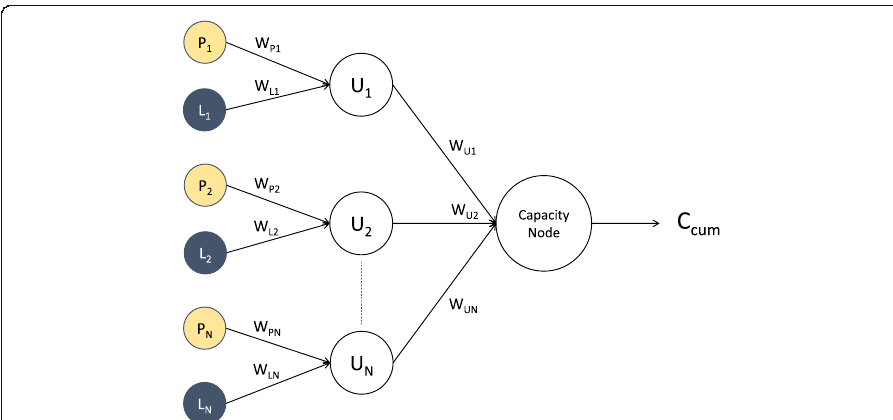
Fig. 4 Architecture of the prediction engine. Probabilities from an individual ’ s user preferences (yellow) and vehicle locations (blue) at the time of the potential market opportunity are input to a layer of nodes for each of the N users (U 1 to U N ). The capacity node predicts overall capacity (C cum ) given predicted outputs for each user weighted by the user ’ s